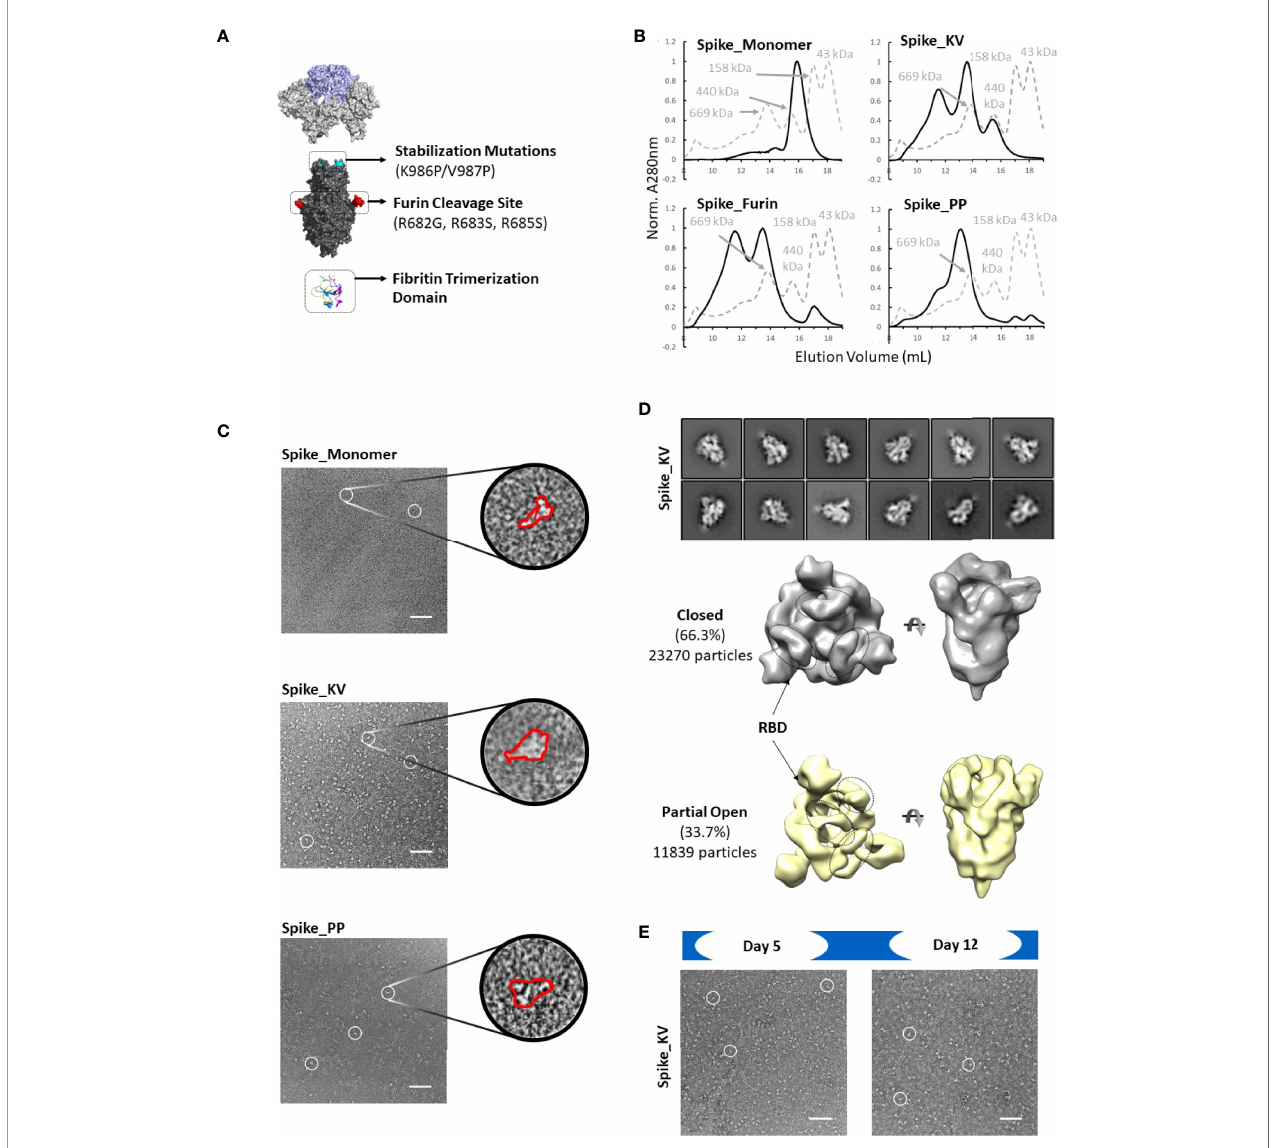
FIGURE 2 | Identi fi cation of spike trimers. Expanded view of the Spike trimer, highlighting the fi britin trimerization domain, furin cleavage site and abrogation mutations, and the prefusion stabilizing mutations K986P/V987P (A) . The effects of stabilization mutations (Spike_PP), removal of the trimerization domain (Spike_Monomer) and re-introduction of the furin cleavage site (Spike_Furin) on the oligomerization state of the Spike protein compared to Spike_KV (Superose 6 SEC chromatograms; Standard elution traces shown in grey) (B) . Negative stain EM images of Spike_Monomer (top), Spike_KV (middle) and Spike_PP (bottom) showing different trimerization and stabilization properties, with zoom-in of individual particles outlined in red; (C) . 2D class average (above) and 3D reconstruction (below) of the Spike_KV construct reveal two distinct Spike trimer populations, closed and partial open (D) . Negative stain EM images of Spike_KV beyond Day 5 after puri fi cation show signi fi cant particle degradation (E) . Scale bars in (C) and (E) indicate 100nm, and white circles highlight individual